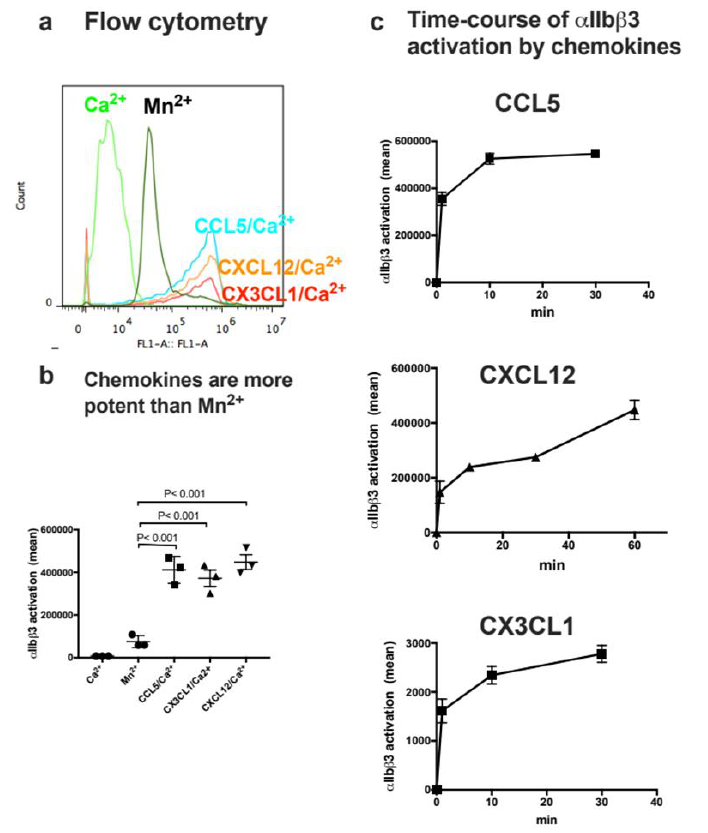
Figure 6. Chemokines activate cell-surface α IIb β 3 in 1 mM Ca 2+ . ( a ) Activation of cell-surface α IIb β 3 on CHO cells. α IIb β 3-CHO cells were incubated with chemokines (50 µ g/mL) for 30 min on ice and then incubated with FITC-labeled γ C390-411 for 30 min at room temperature. The cells were washed with PBS/0.02% BSA and analyzed by flow cytometer. Data are shown as mean fluorescence intensity +/ − SD in triplicate experiments. ( b ) Comparison of activation of cell-surface α IIb β 3 by 1 mM Mn 2+ and chemokines in 1 mM Ca 2+ . α IIb β 3-CHO cells were incubated with chemokines as described in ( a